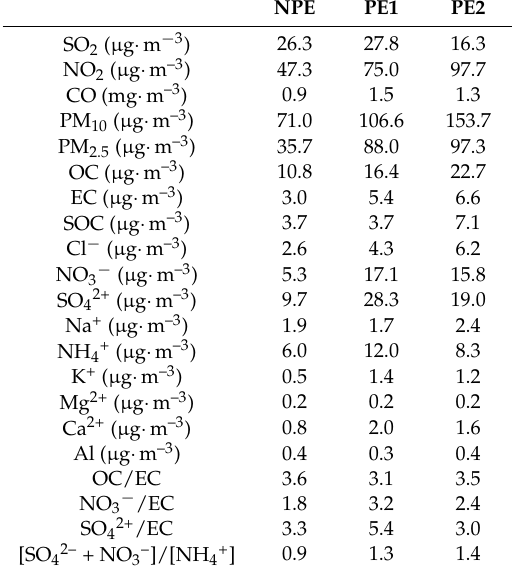
Table 1. Average concentrations of particulate matters, gaseous pollutants, and the major species in PM 2.5 and average mass ratios of chemical species in the non-pollution period from 12–16 October (NPE) and the two pollution episodes from 20 ´ 23 October (PE1) and from 26–29 October